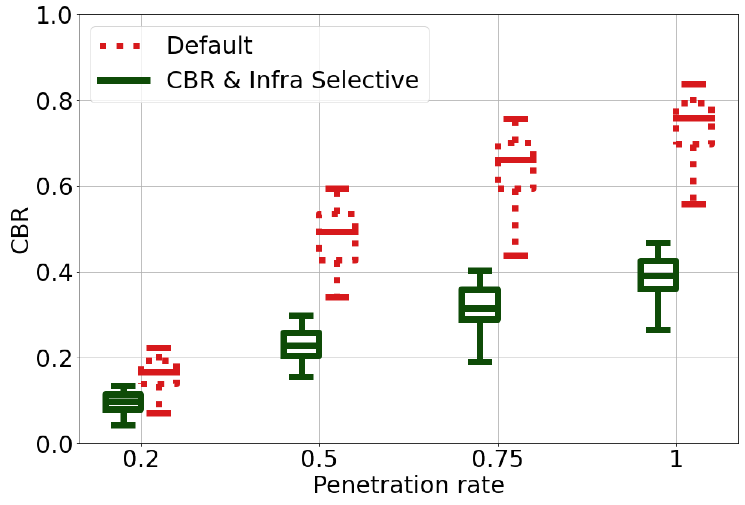
Figure 9. CBR function of penetration rate for Default, CBR & Infra selective